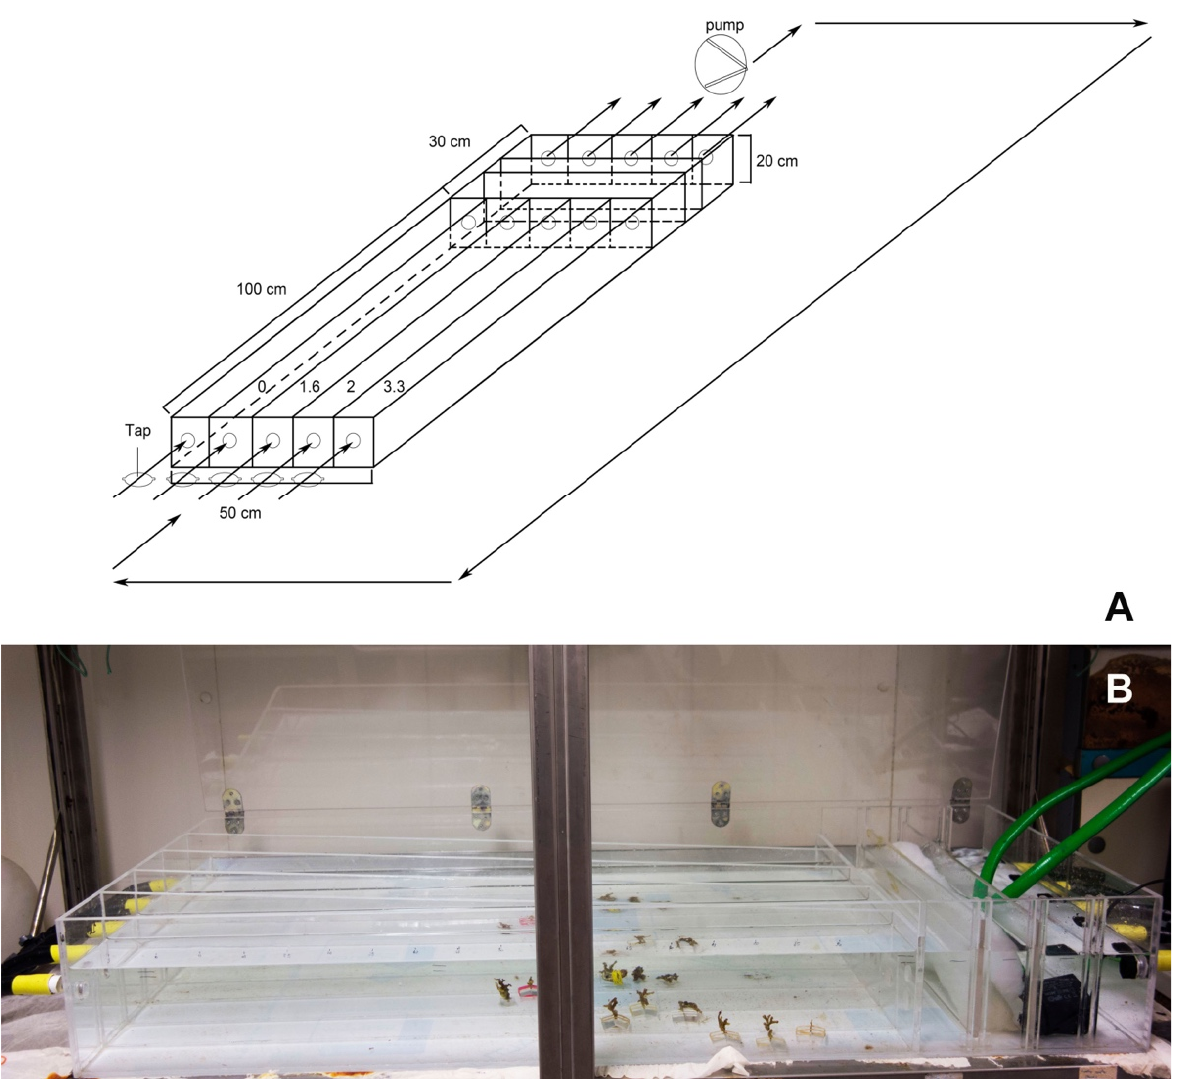
Figure 3. The experimental flow channel aquarium. ( A ) Drawing and ( B ) photograph of the experimental aquarium with flow channels. One channel was used for control, with 0 cm/s flow, and three channels were maintained at flow velocities of 1.6 cm/s, 2 cm/s, and 3.3 cm/s. In figure ( A ), arrows indicate the direction of flow, and velocities in cm/s are reported on each channel. Only four of the five channels were used.